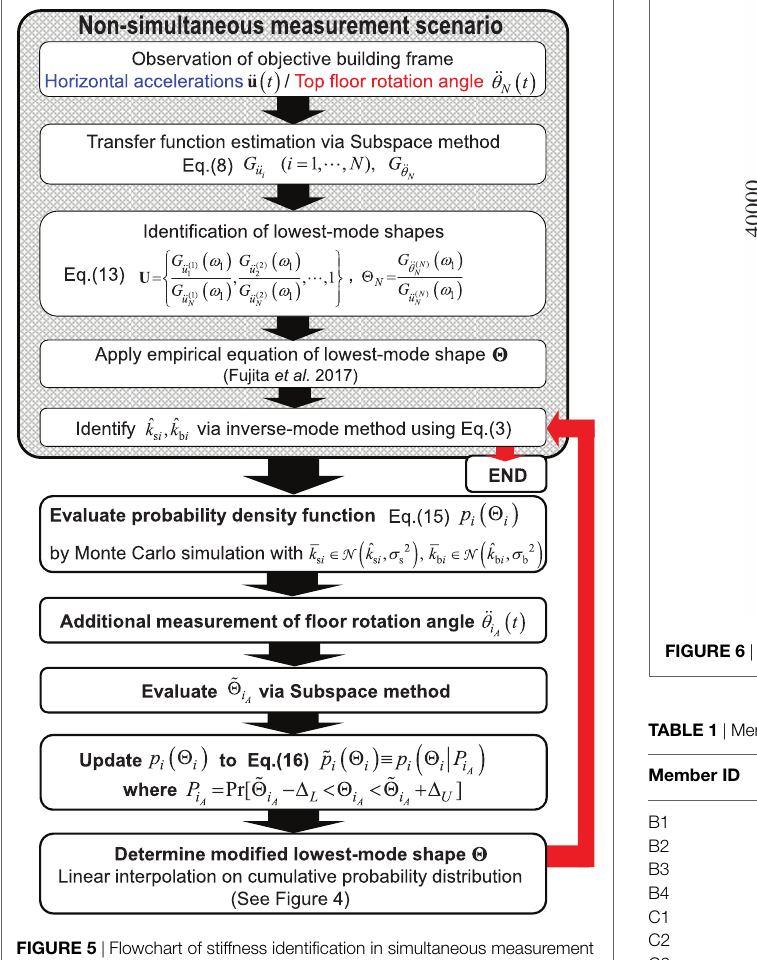
FIGURE 5 | Flowchart of stiffness identification in simultaneous measurement scenario.